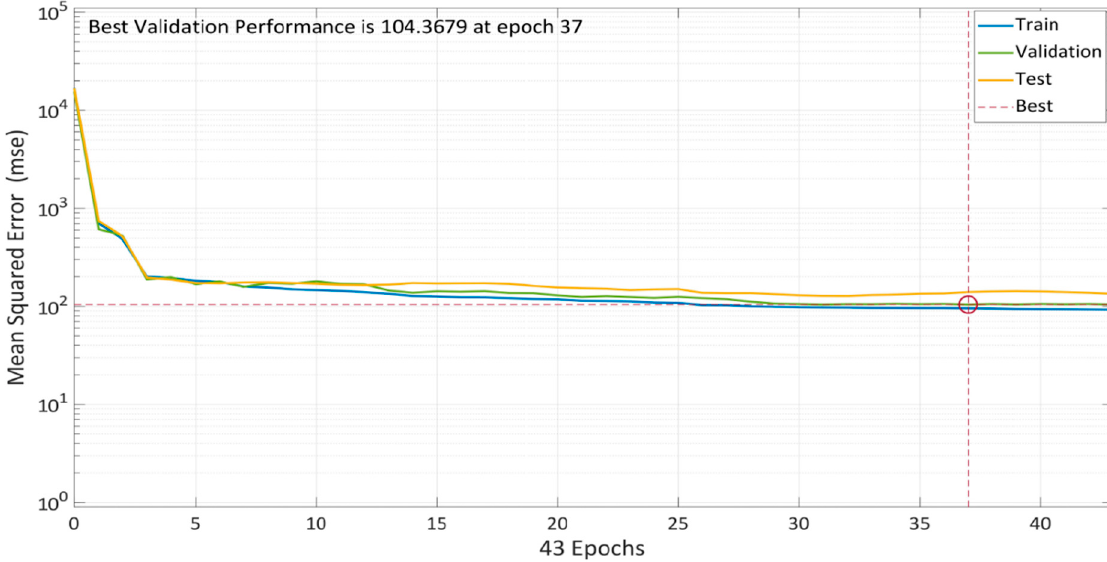
Figure 16. Model performance using SCG algorithm.